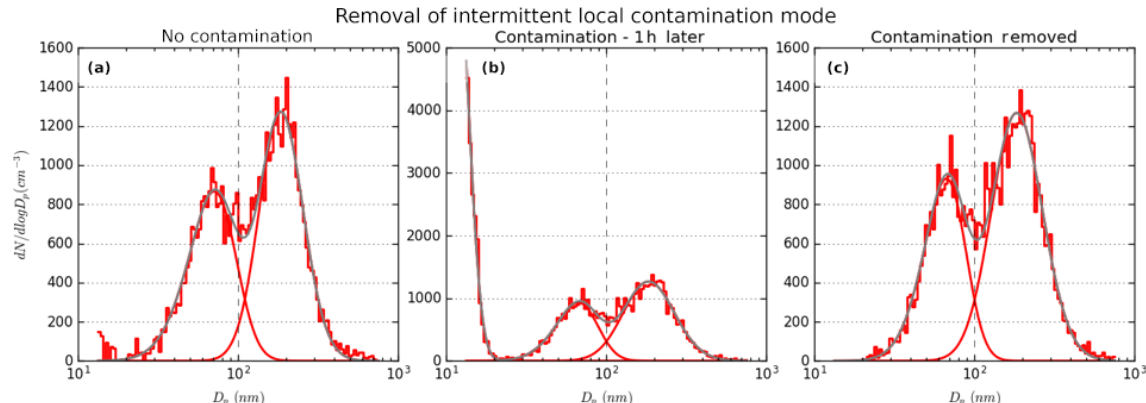
Figure 1. Example removal of intermittent local contamination mode. (a) An observed size distribution with limited impacts from the smallest nucleation mode particles. (b) An observation approximately 1h later with contamination from small particles that are not representative of the regional aerosol. (c) The same size distribution as in (b) , but with the smallest contamination mode identified and removed as described in the text.